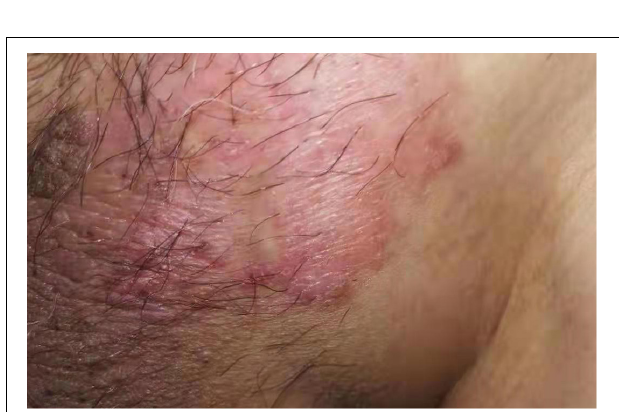
FIGURE 2 | The perineal lesions were about 4 cm × 3 cm in size, with obvious rash, erythema and erosion, accompanied by pruritus, no pain and